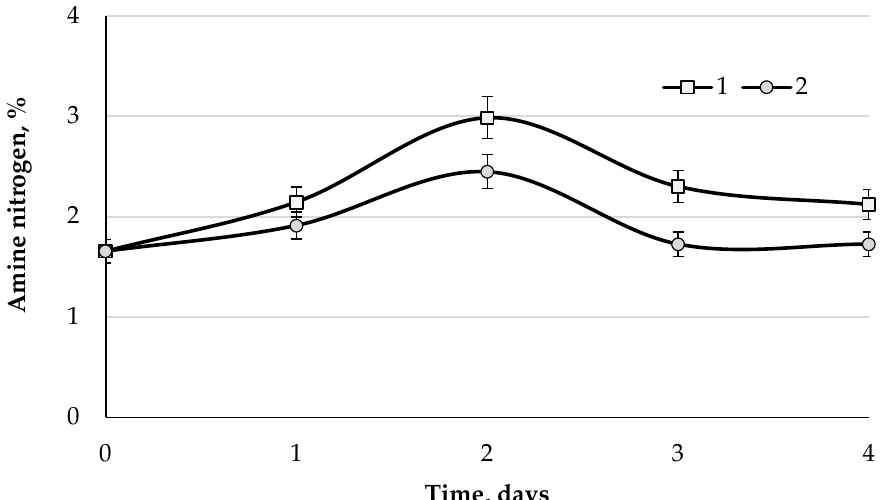
Figure 1. Dynamics of amine nitrogen accumulation during SBM hydrolysis by a mixed culture of probiotic microorganisms for different hydromodulus values (SBM:water): 1—30:110; 2—30:130.